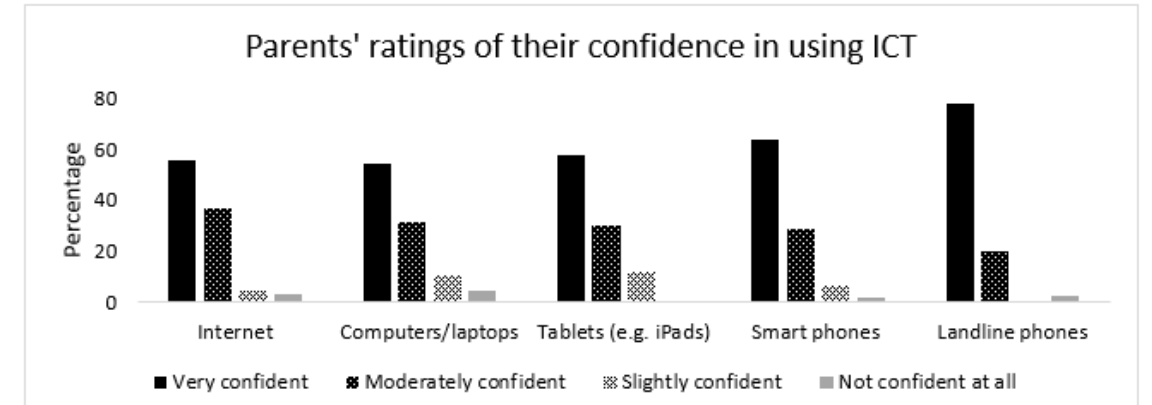
Figure 5. Parents’ rating of their confidence in using ICT.